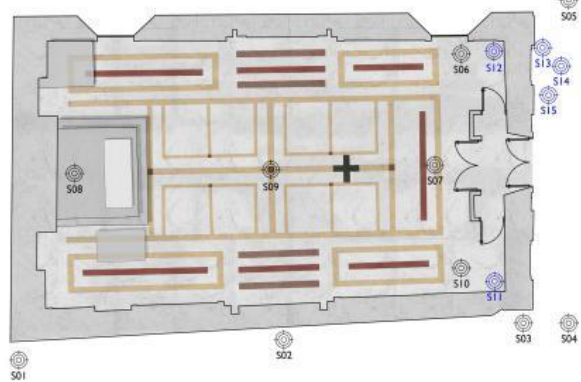
Figure 3. The acquisition network schema